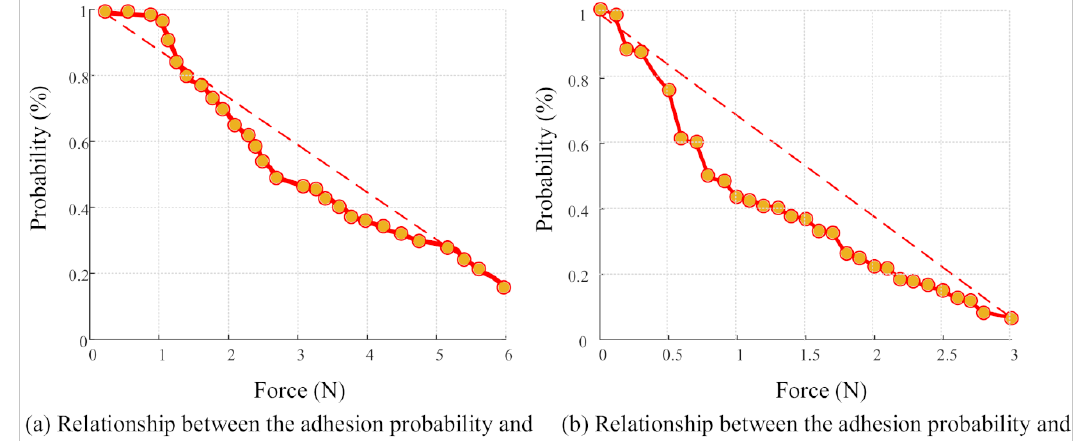
Figure 6. Relationship between the pull force and the adhesion